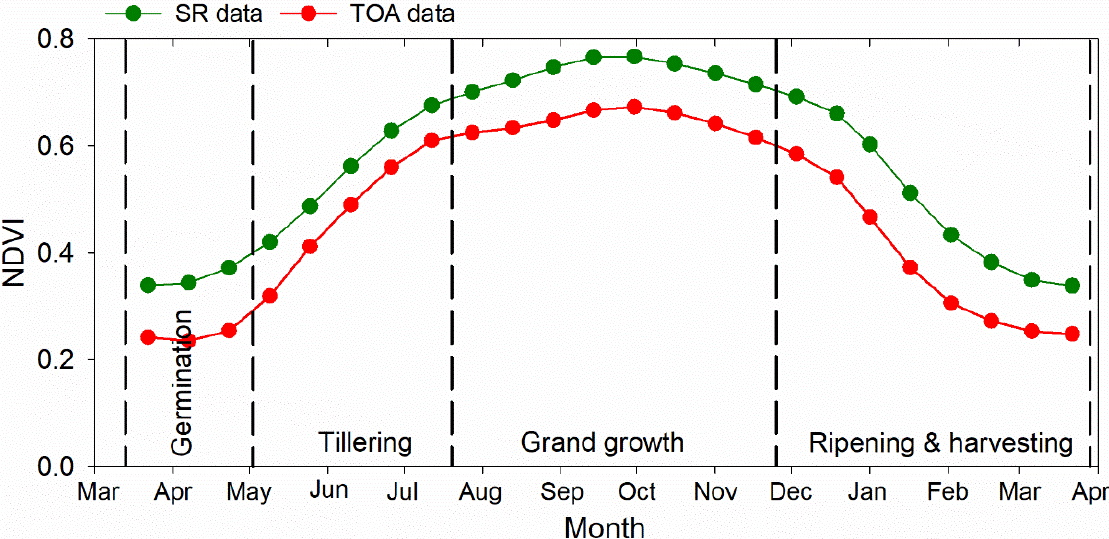
Figure 3. Temporal patterns of NDVI (standard NDVI curves) and growing stages for sugarcane in China for both SR and TOA data. China for both SR and TOA